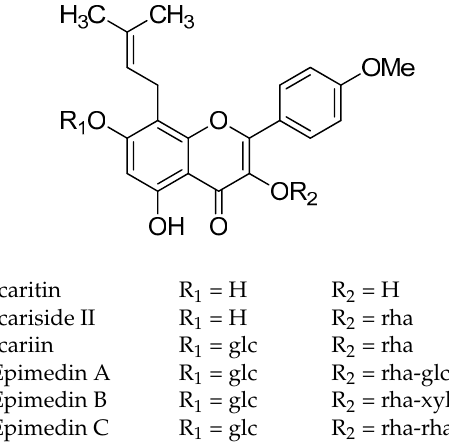
Figure 2. Chemical structures of the compounds. Table 2. Abilities of Epimedium koreanum- derived compounds to inhibit protein PTP1B and α -glucosidase.